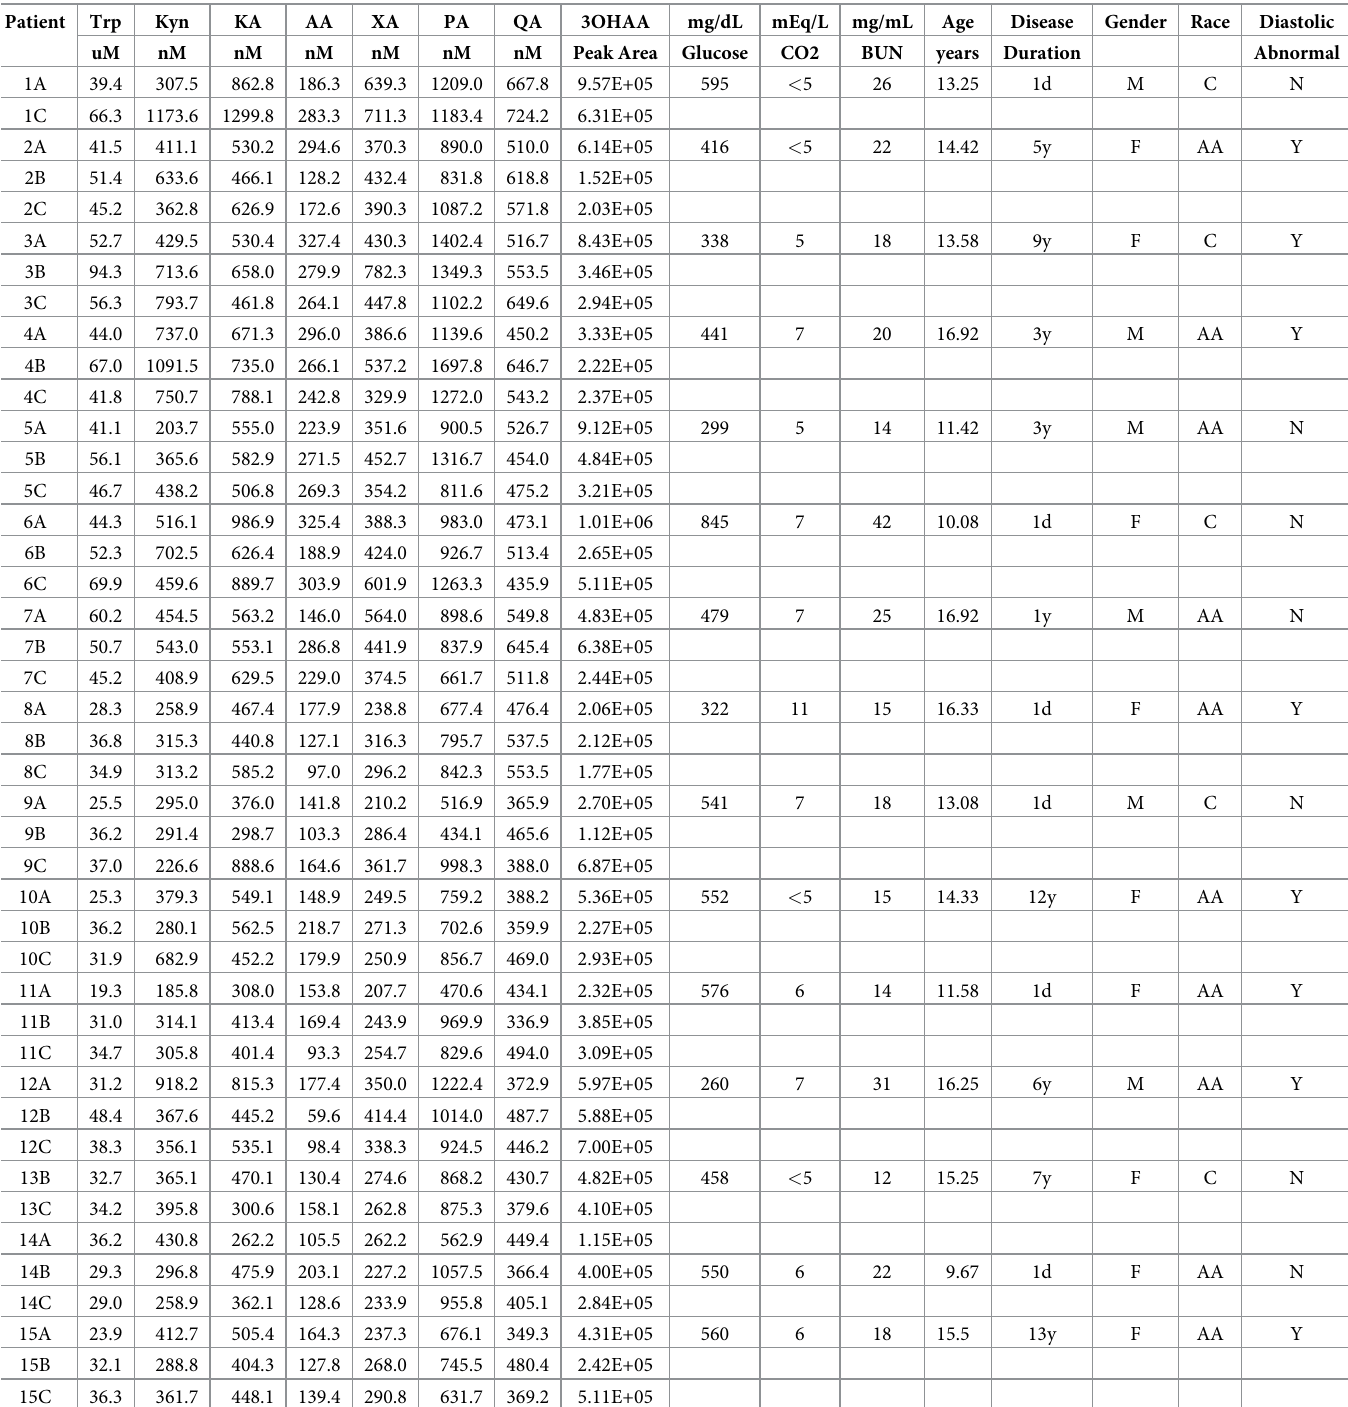
Table 1. Tryptophan/Kynurenine pathway metabolite concentrations in T1D